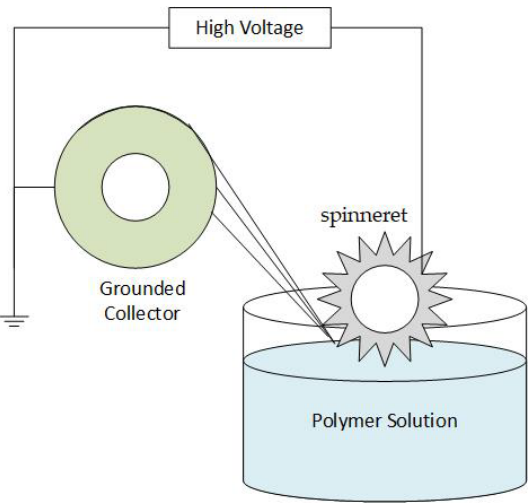
Figure 2. Schematic of Formhals’ electrospinning apparatus .